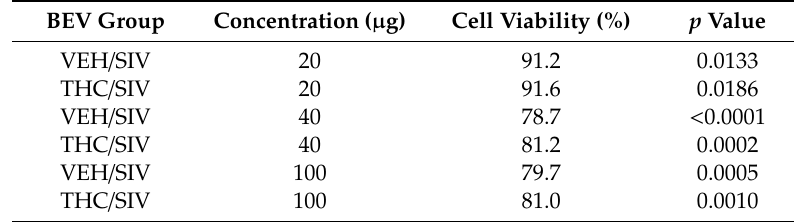
Table 3. The e ff ect of BEV from uninfected and untreated RMs on U937 cell viability. BEV